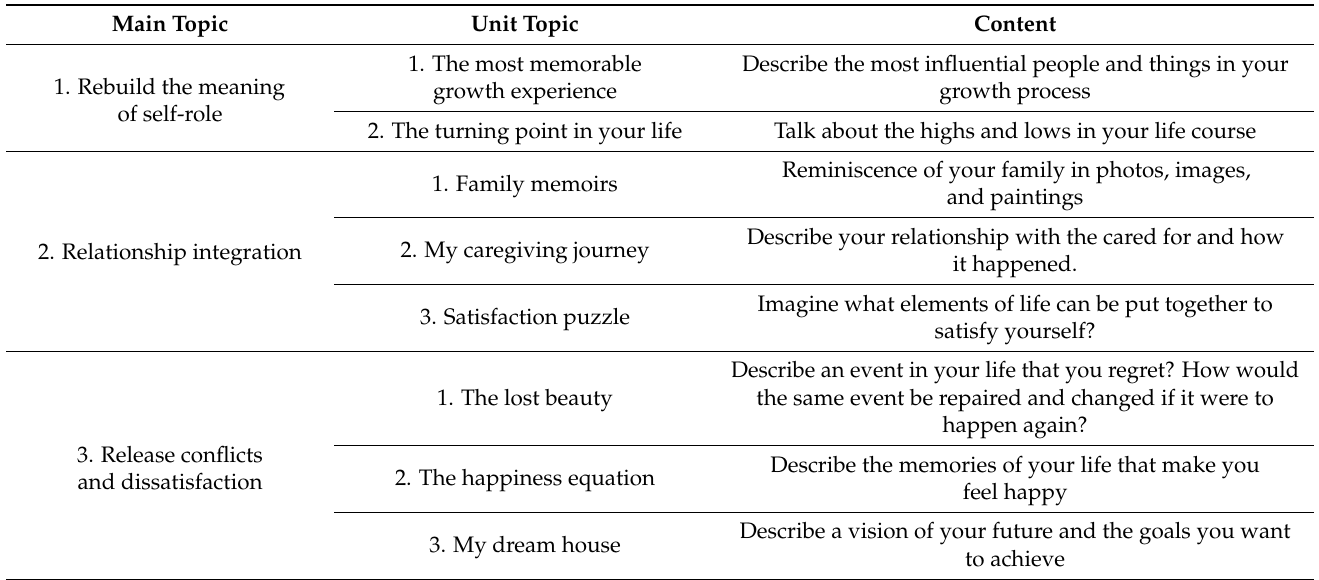
Table 2. Topic design and content of life review